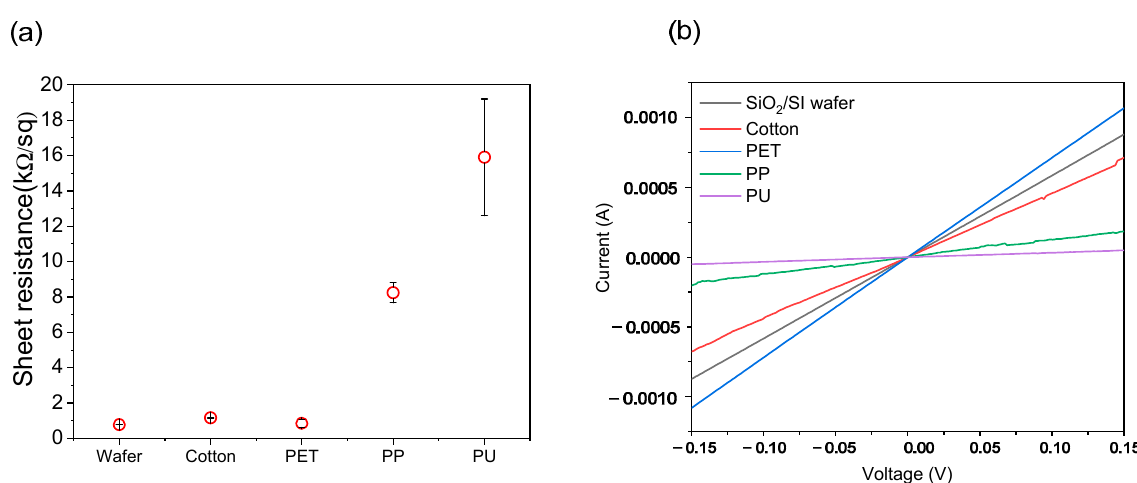
Figure 4. Electrical properties of transferred graphene on EVA with various flexible substrates, ( a ) sheet resistance and ( b ) I-V curves.